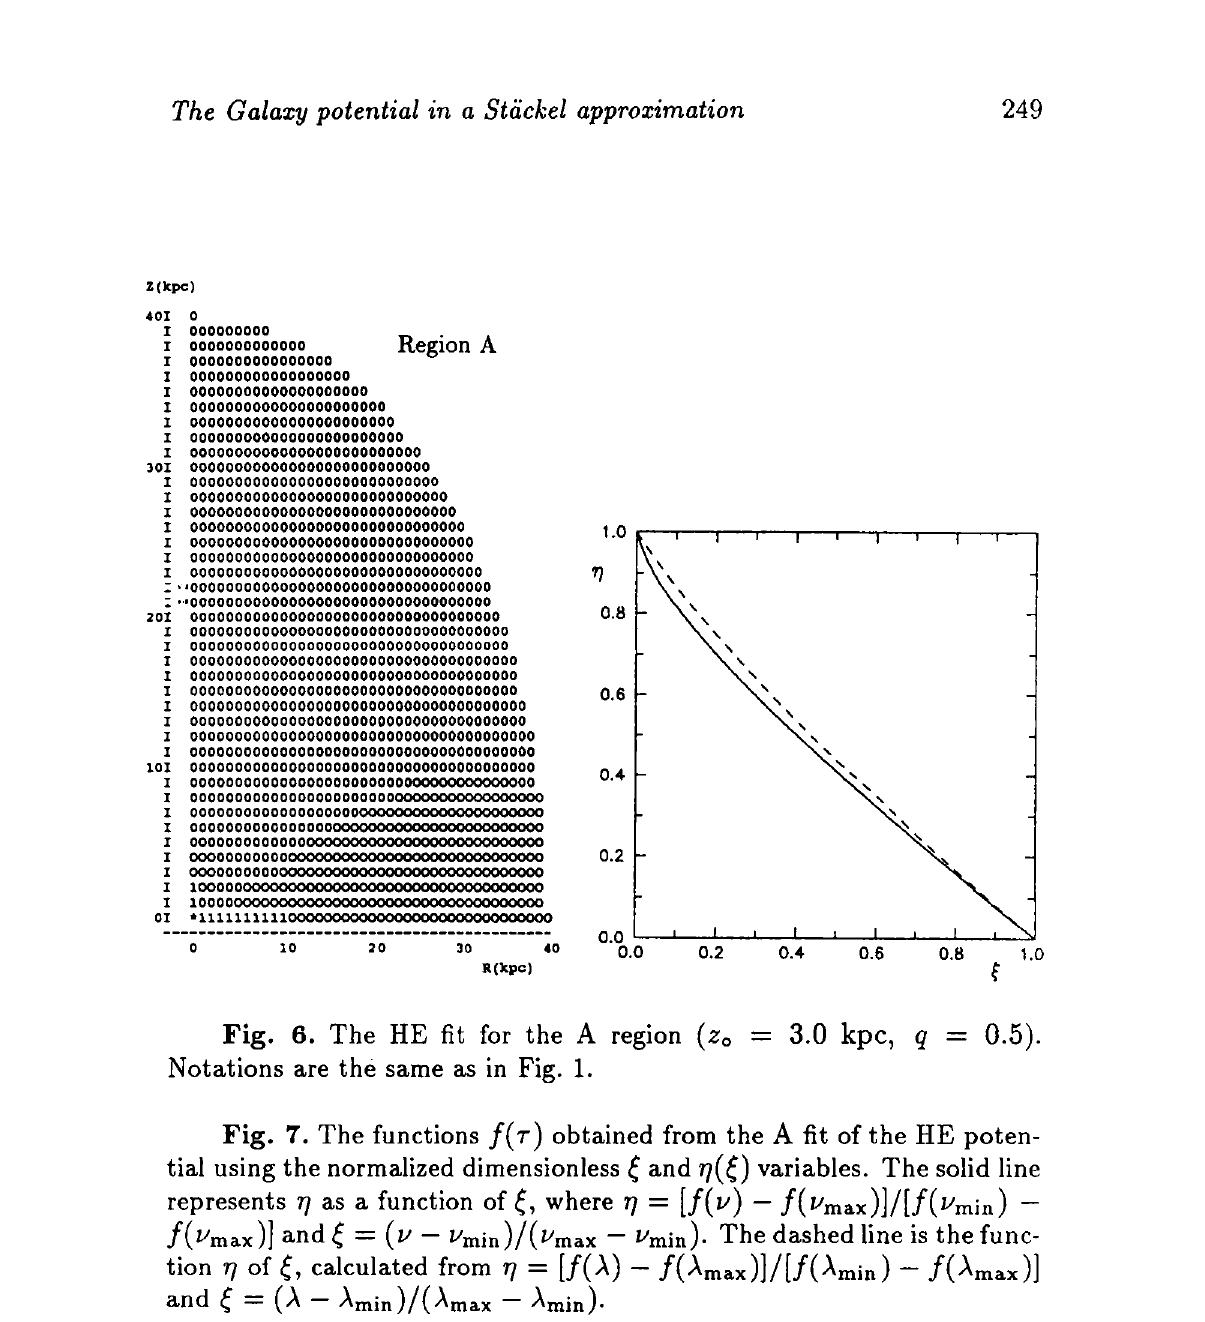
Fig. 6. The HE fit for the A region (z a = 3.0 kpc, q = 0.5). Notations are the same as in Fig. 1. Fig. 7. The functions /(r) obtained from the A fit of the HE poten- tial using the normalized dimensionless £ and variables. The solid line represents 77 as a function of where 77 = [f(u) — f(vma.x)]/[f(vmm) — /(fmax)] and ( = ( u- U min )/( ^max — ^min)- The dashed line is the func- tion 77 of f, calculated from 77 = [/(A) - /(A max )]/[/(A min ) - /(A max )] and £ = (A — A m i n )/(A max — A m j n